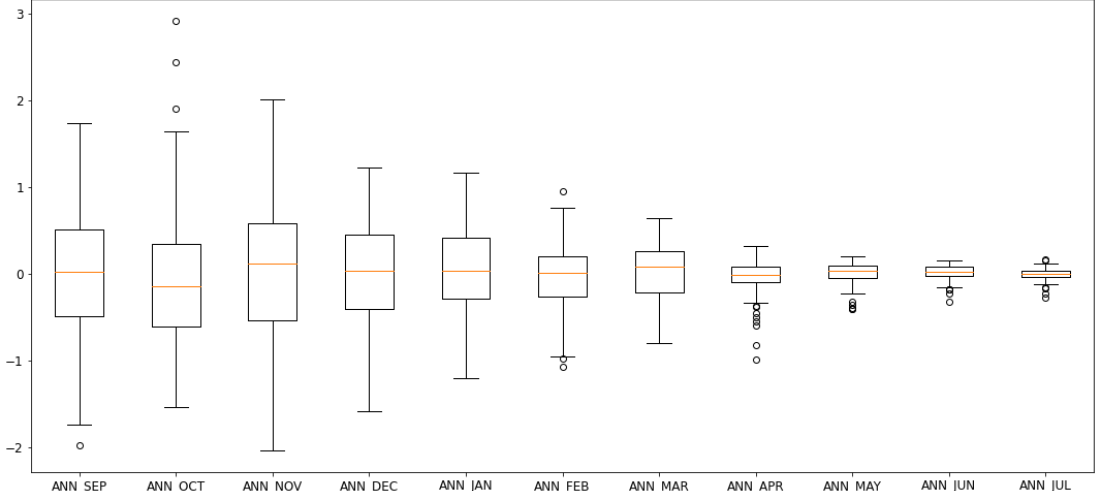
Figure 8. Boxplots showing the error distributions of the SPEIs in the test phase. The horizontal line shows the median errors, lower box shows negative errors, circles indicate outlier error values.